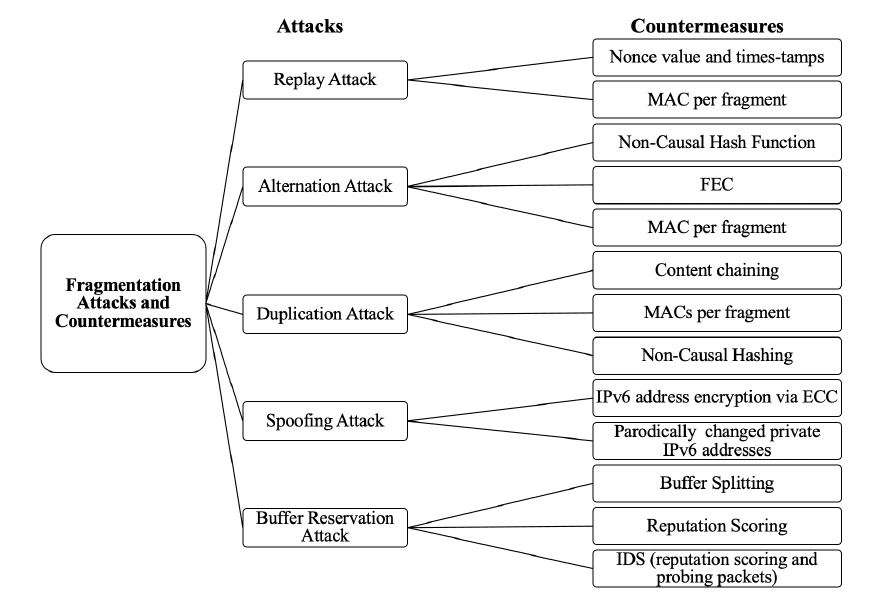
Figure 10. Taxonomy of fragmentation attacks and